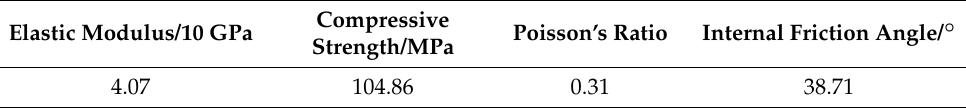
Table 2. Mechanical properties of igneous rocks.